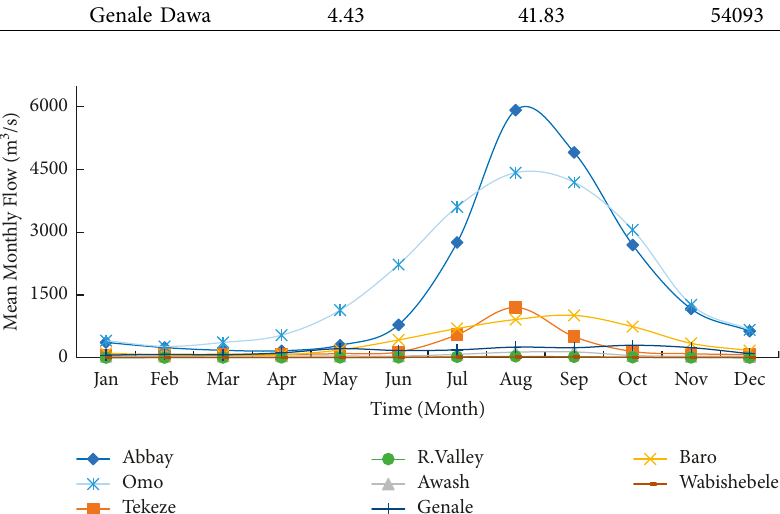
Figure 3: Seasonal variation of mean monthly streamflow over Ethiopian River